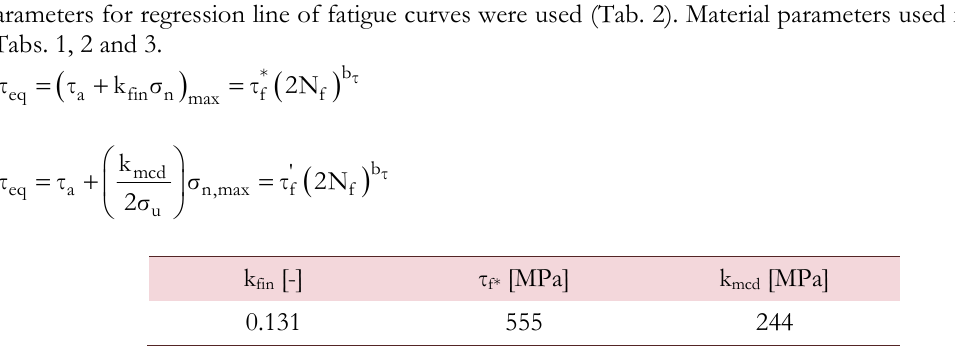
Table 3: Material parameters for Eqs 9 and 10